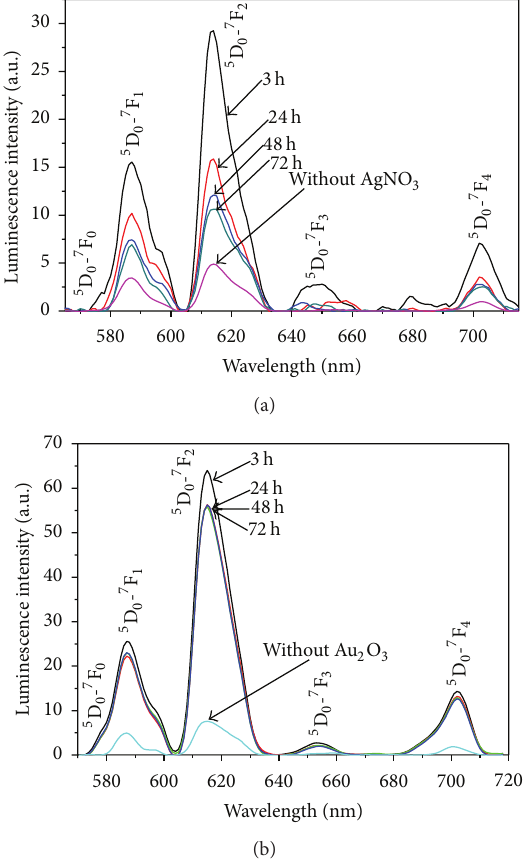
Figure 2: Luminescence spectra of the Eu 3+ doped samples heat- treated for different times. (a) PGO-Eu:Ag. (b) BGO-Eu:Au. Also presented are the spectra of both glasses without metallic